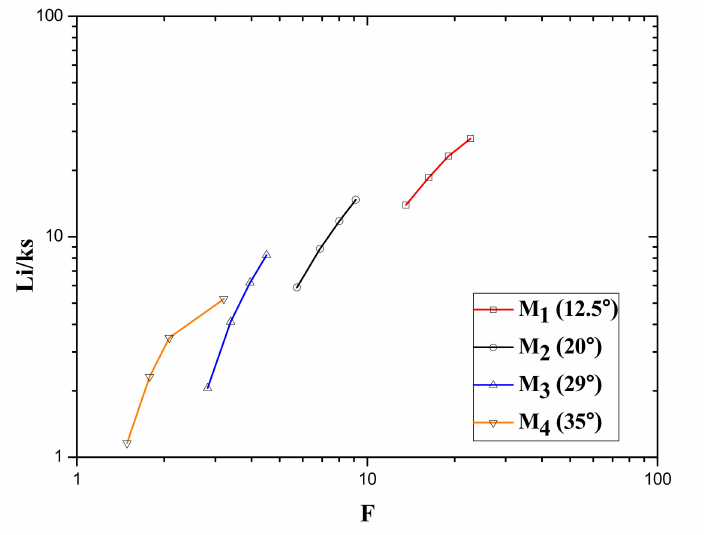
Figure 8. Variation of normalized Li with the Froude number of different sloped stepped spillway models. Li/ks is the normalized distance from the crest of the spillway to the inception